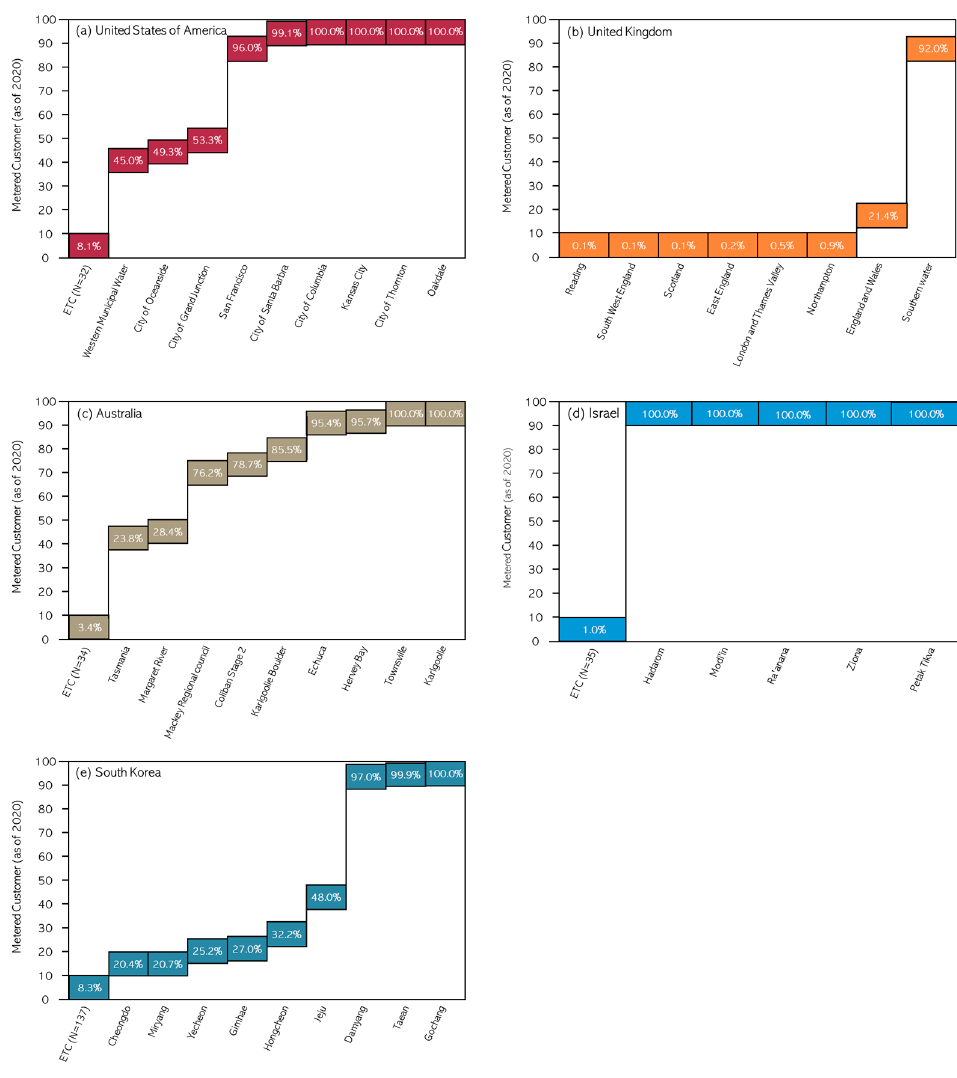
Figure 1. Smart water metering implementation status of several cities in ( a ) United States of America, ( b ) United Kingdom, ( c ) Australia, ( d ) Israel, and ( e ) South